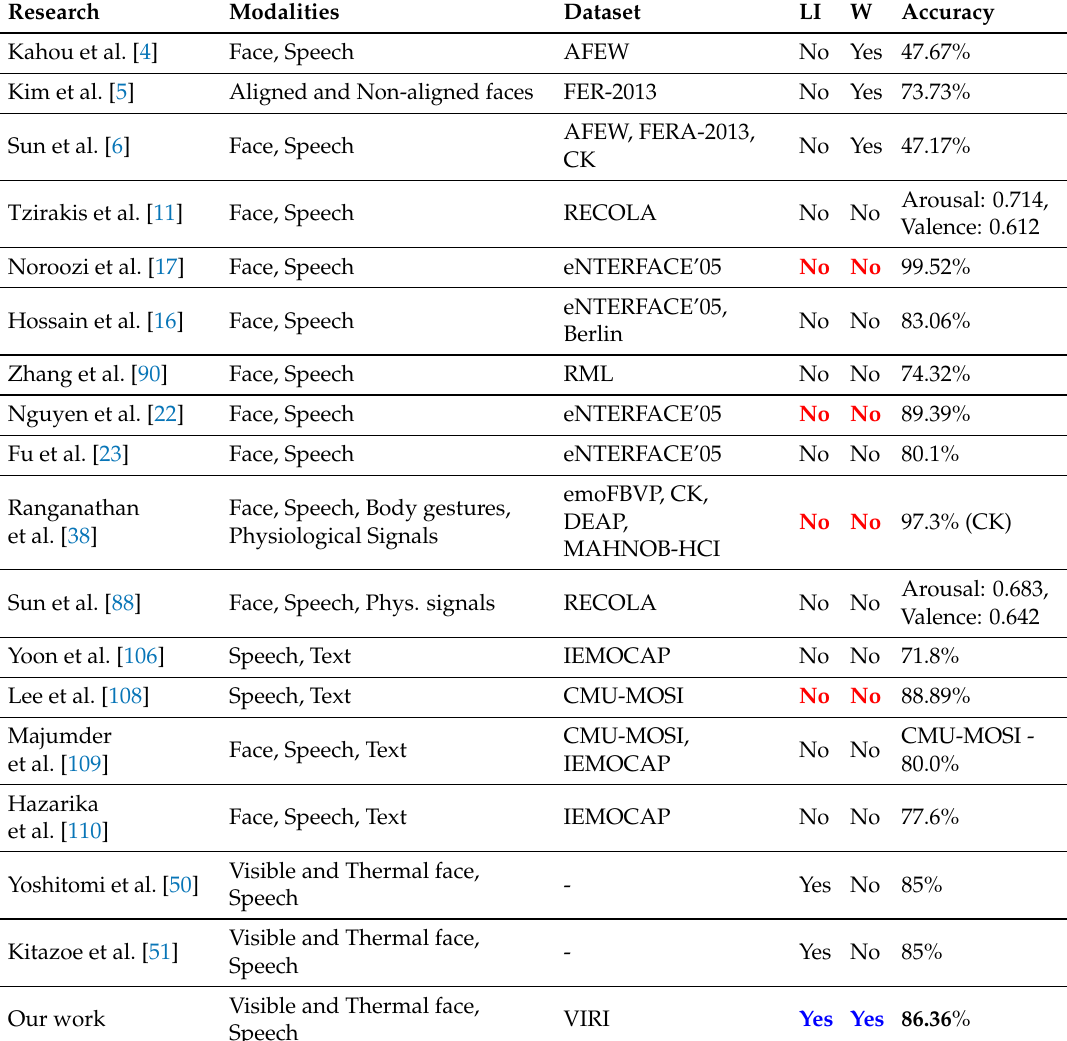
Table 4. Comparison of state-of-the-art in multimodal AER with the proposed